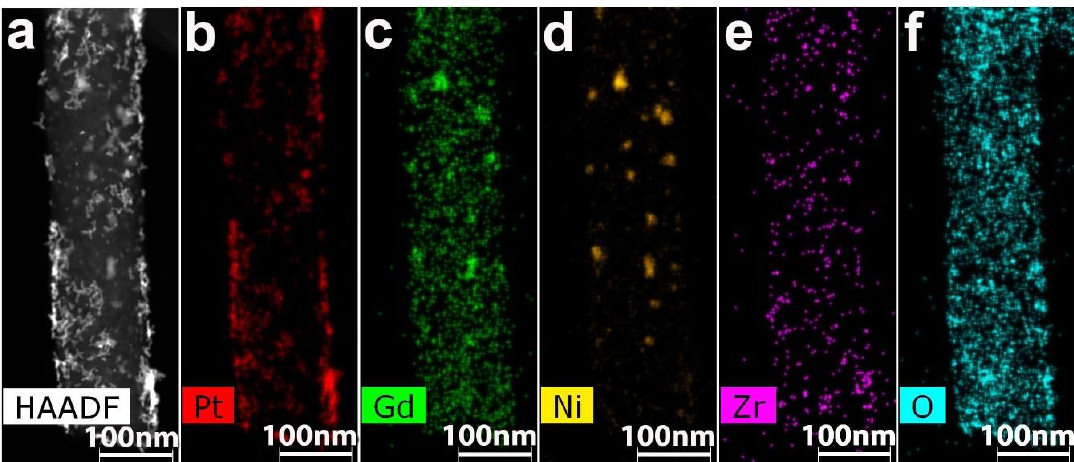
Figure 8. ( a ) HAADF STEM image; EDX distribution maps for ( b ) Pt, ( c ) Gd, ( d ) Ni, ( e ) Zr and ( f ) O for Figure 8. (a) HAADF STEM image; EDX distribution maps for (b) Pt, (c) Gd, (d) Ni, (e) Zr and (f) O the Pt / 2 for the Pt/2 composite.